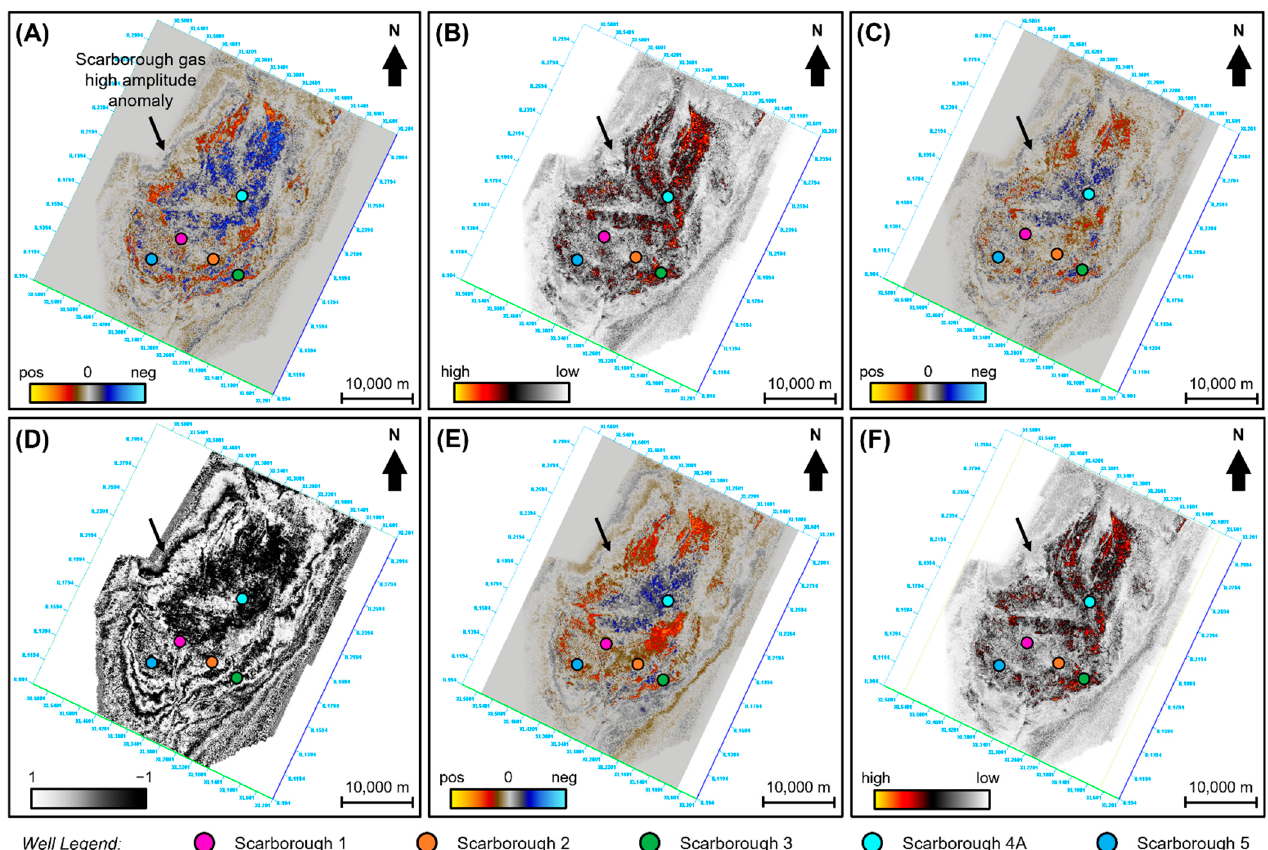
Figure 12. All the attributes taken at time slice 2.169 s from the KK/LA PCA that were used as an input into the Scarborough SOM where ( A ) is the full-stack amplitude, ( B ) is the envelope, ( C ) is the Hilbert, ( D ) is the cosine of instantaneous phase, ( E ) is the relative acoustic impedance, and ( F ) is the sweetness.